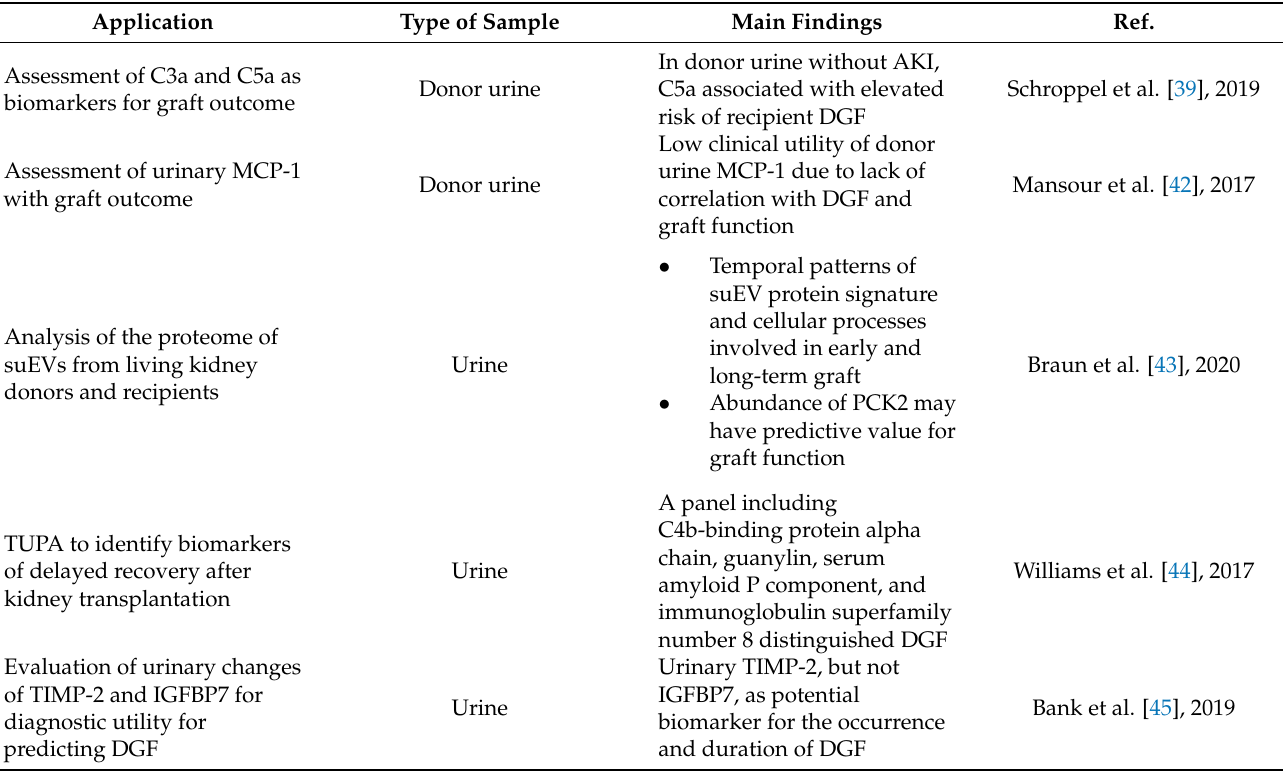
Table 3. Recent proteomic studies on delayed graft function in the setting of kidney